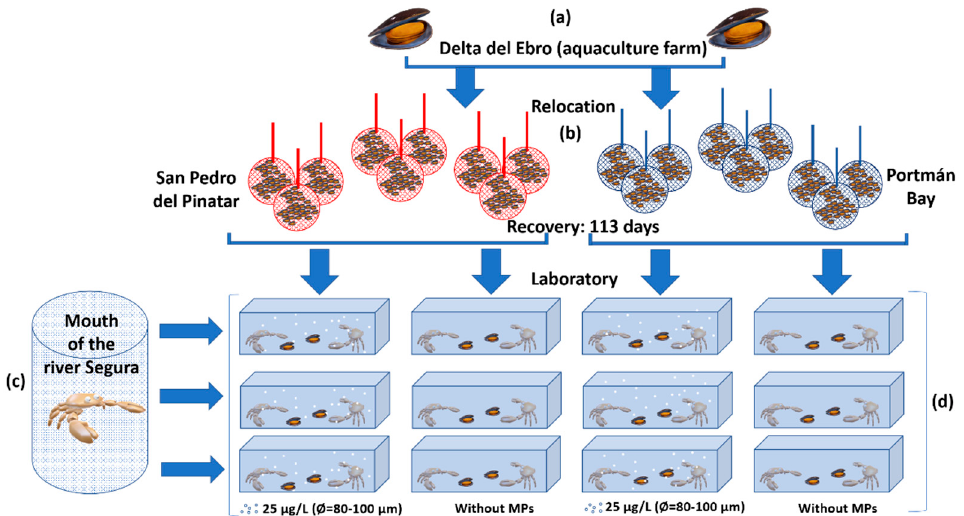
Figure 1. Phases of the study: ( a ) mussel acquisition (aquaculture farm, Delta del Ebro, Spain), ( b ) mussel relocation (San Pedro del Pinatar and Portmán Bay, Spain), ( c ) crab collection (mouth of the river Segura, Spain), and ( d ) experimental procedure (crabs fed on mussels from San Pedro del Pinatar or Portmán Bay, with or without microplastics (MPs) in the water).